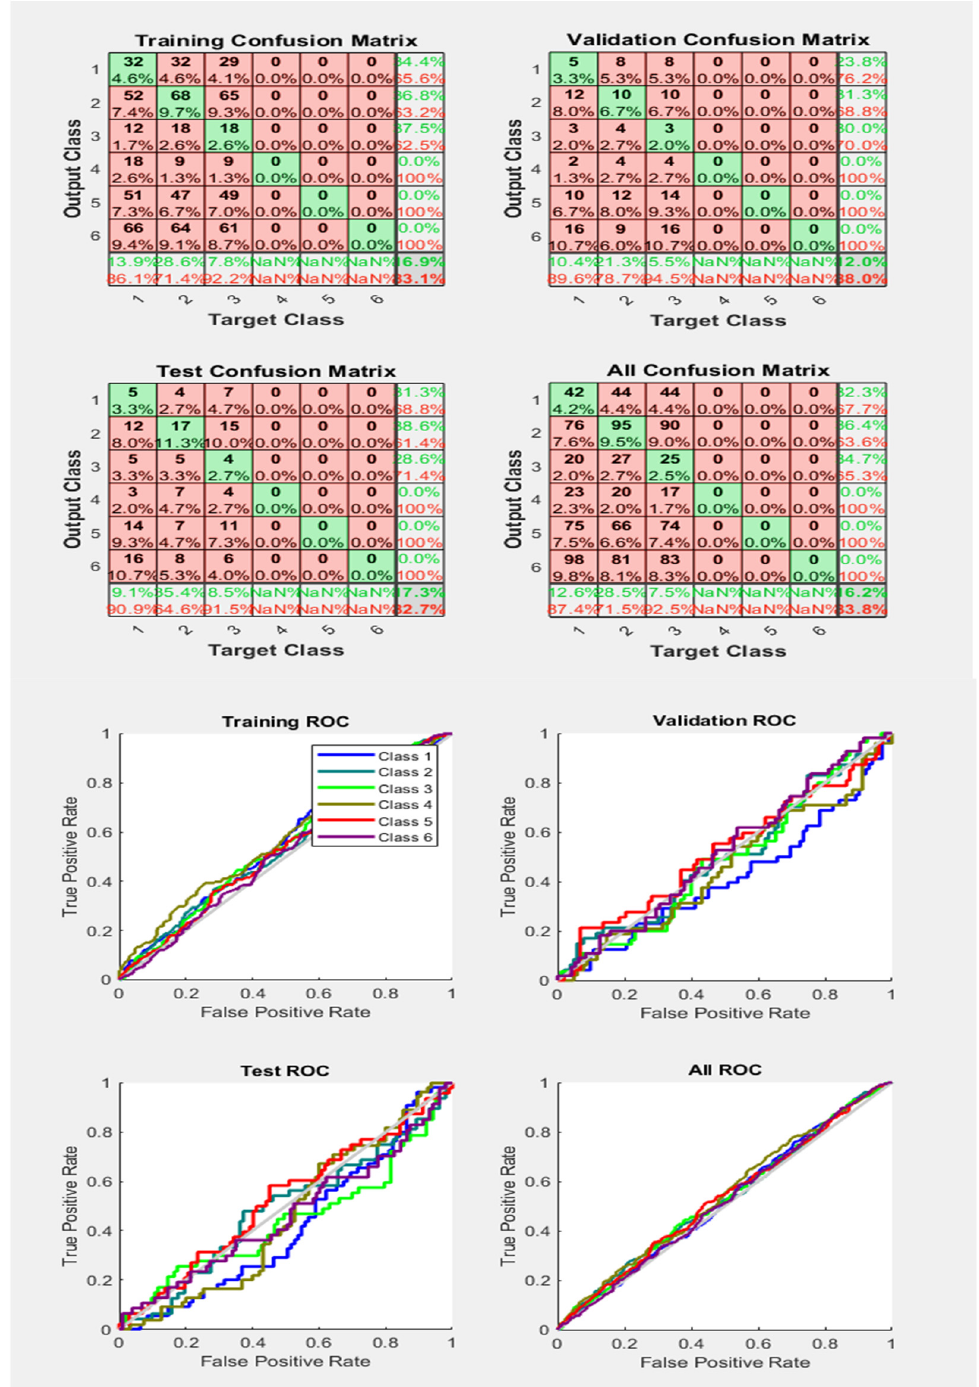
Figure 22. Neural Network Model ROC (Receiver Operating Characteristics) and Confusion Matrix for OSS TrainFcn/Activation Function at level 9 (RMS) Features for Rotor Bar Fault with 83.8% Accuracy. Grey line shows diagonal of the ROC for indicating Class 1–6 lines are lying above or below or on it.